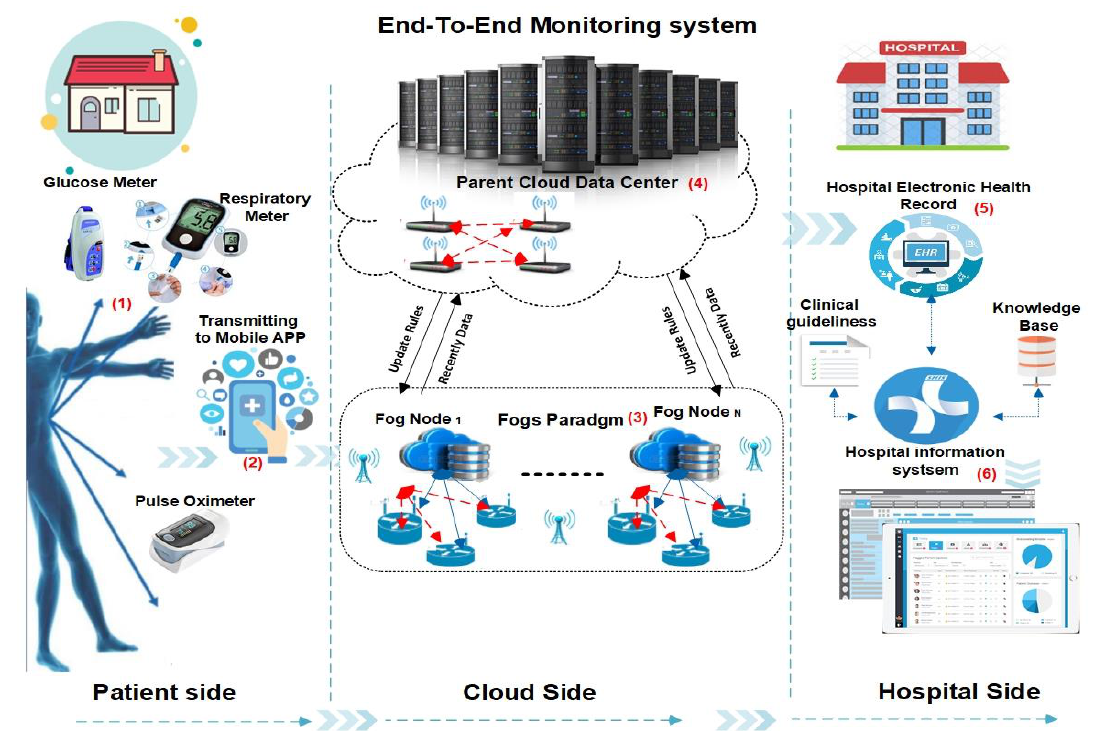
Figure 4. The proposed framework.